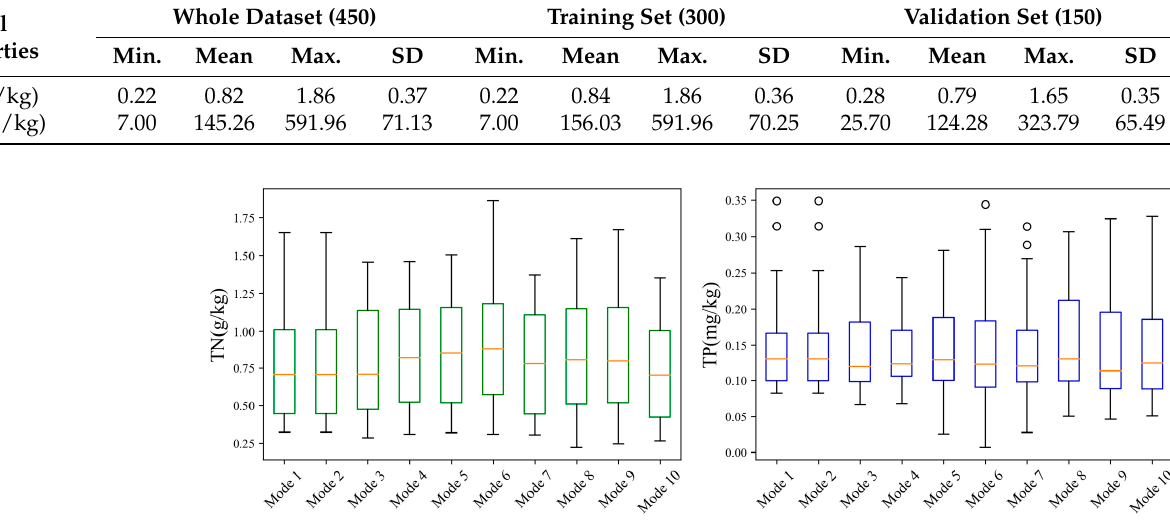
Figure 2. Box plot of soil properties (TN and TP) under di ff erent farming practices.